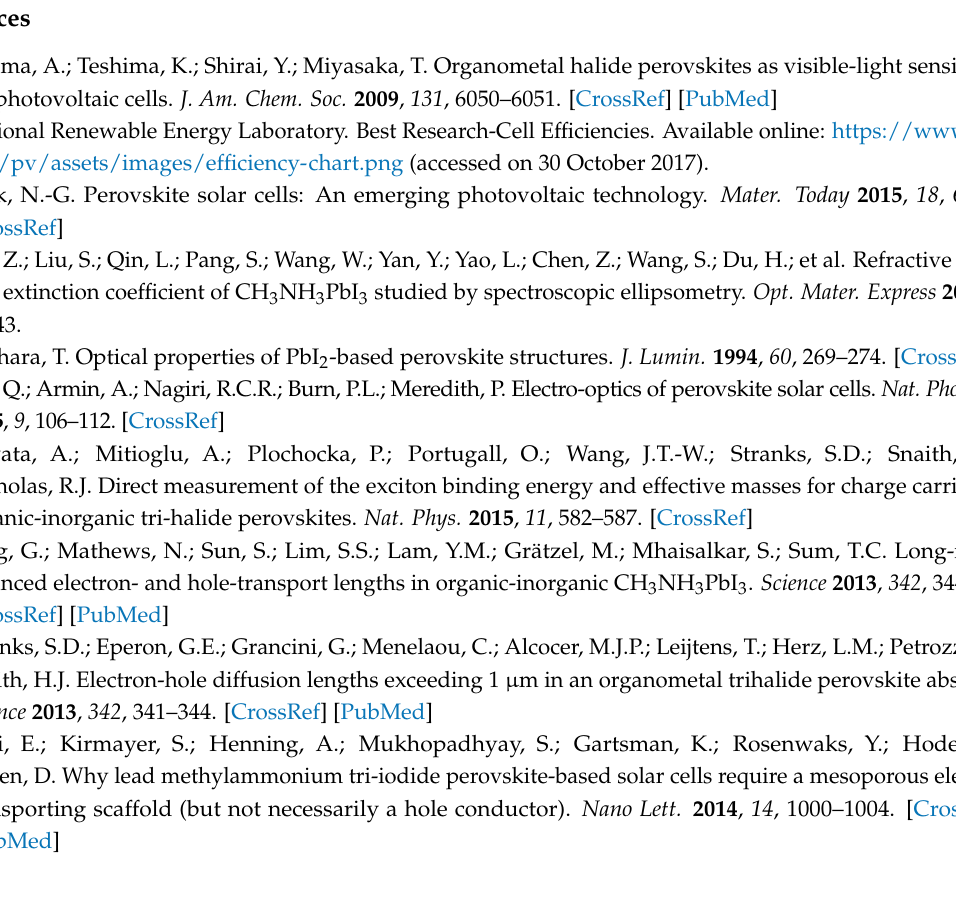
Figure A5. The schematic drawing illustrates the difference to the MA vapor treatment ( a ) and the ethanol vapor treatment ( b ).